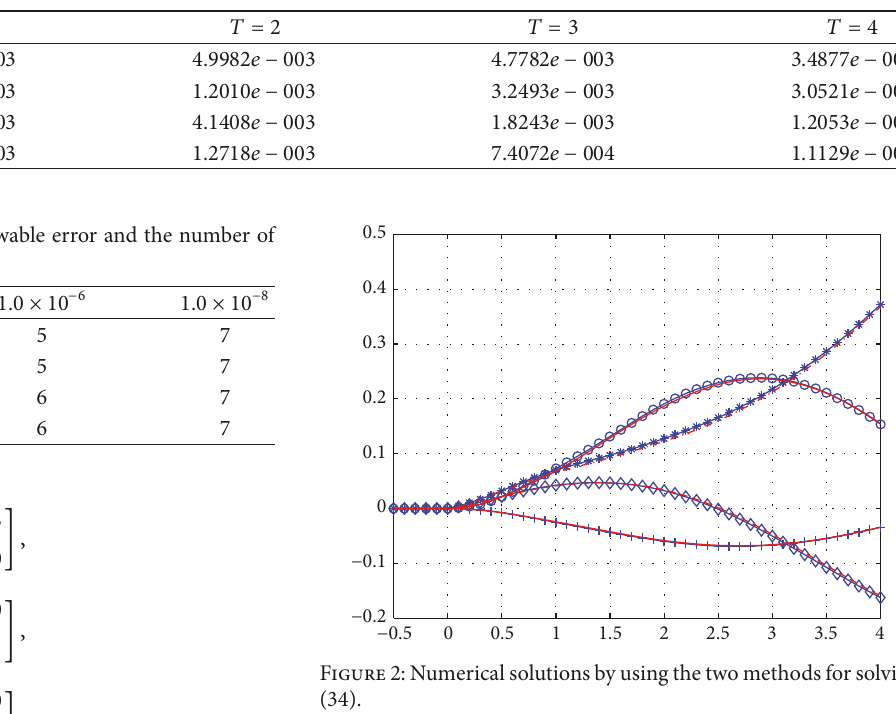
Table 3: The error of numerical solutions.